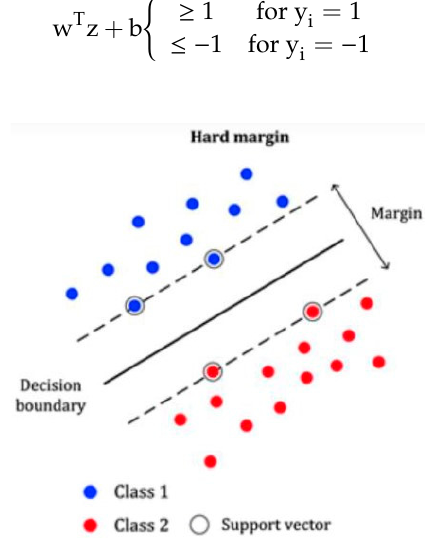
Figure 1. The case of hard margin where data are easily separable.